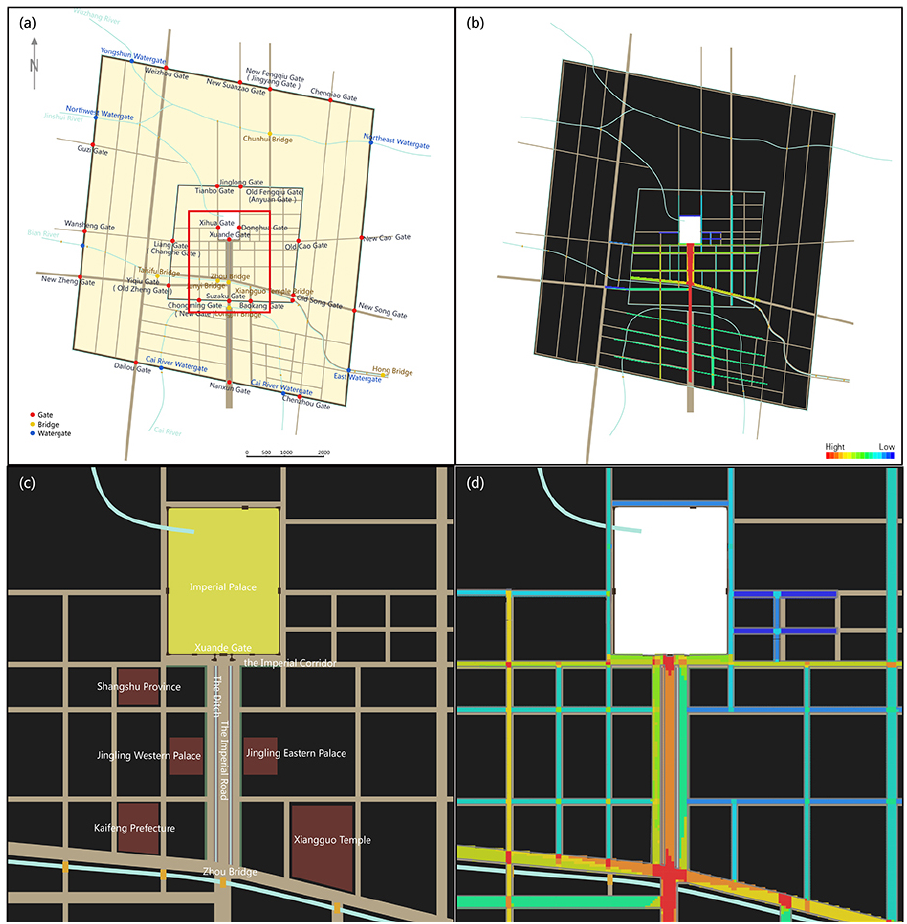
Figure 19. ( a ) Recovery plan of Dongjing City of the Song Dynasty (1102–1125), ( b ) the visual integration of the square in front of Xuande Gate in Dongjing City of the Song Dynasty, ( c ) the street in front of Xuande Gate,the isovist connectivity value of the square in front of Xuande Gate in Dongjing City of the Song Dynasty ( d